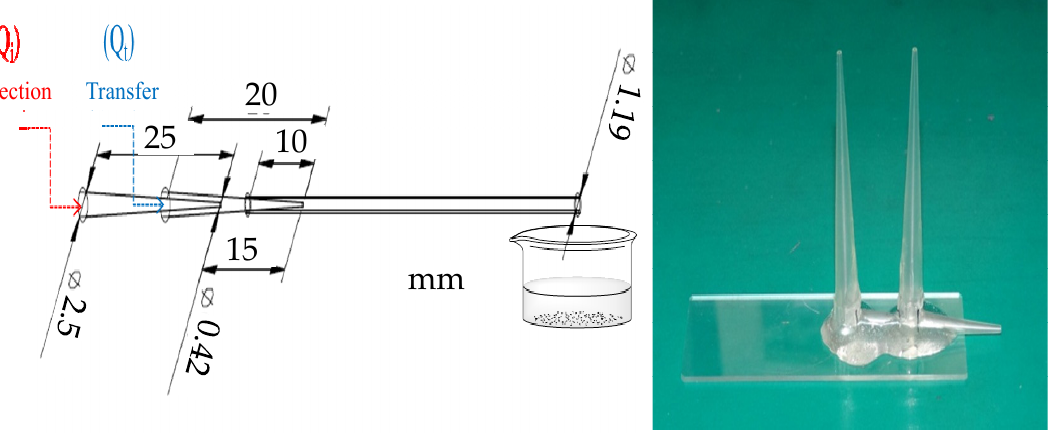
Figure 2. Two-tube microfluidic device ( left ) chart, ( right ) entity picture. The 1.5% alginate (containing 2% chitosan) was injected into the two-tube microfluidic device through the injection tube by the microsyringe, and isooctane was injected into the two-tube microfluidic device using the transfer tube. After that, the flow rate of the injection tube was fixed at 100 µ L/min, and the flow rate of the transfer tube was fixed at 1000 µ L/min. The alginate mixture was cut into droplets by isooctane and flowed into the aqueous solution of curing agents (CaCl 2 , ZnCl 2 ) to form alginate/chitosan microcapsules through curing. In the process of suction and filtration, deionized water was used for clean- ing to obtain composite wet pellets of alginate/chitosan. Finally, they were vacuumized and dried to obtain composite microcapsules of alginate/chitosan. The diameter of the composite microcapsules of alginate/chitosan was about 450 µ m, as shown in Figure 3.